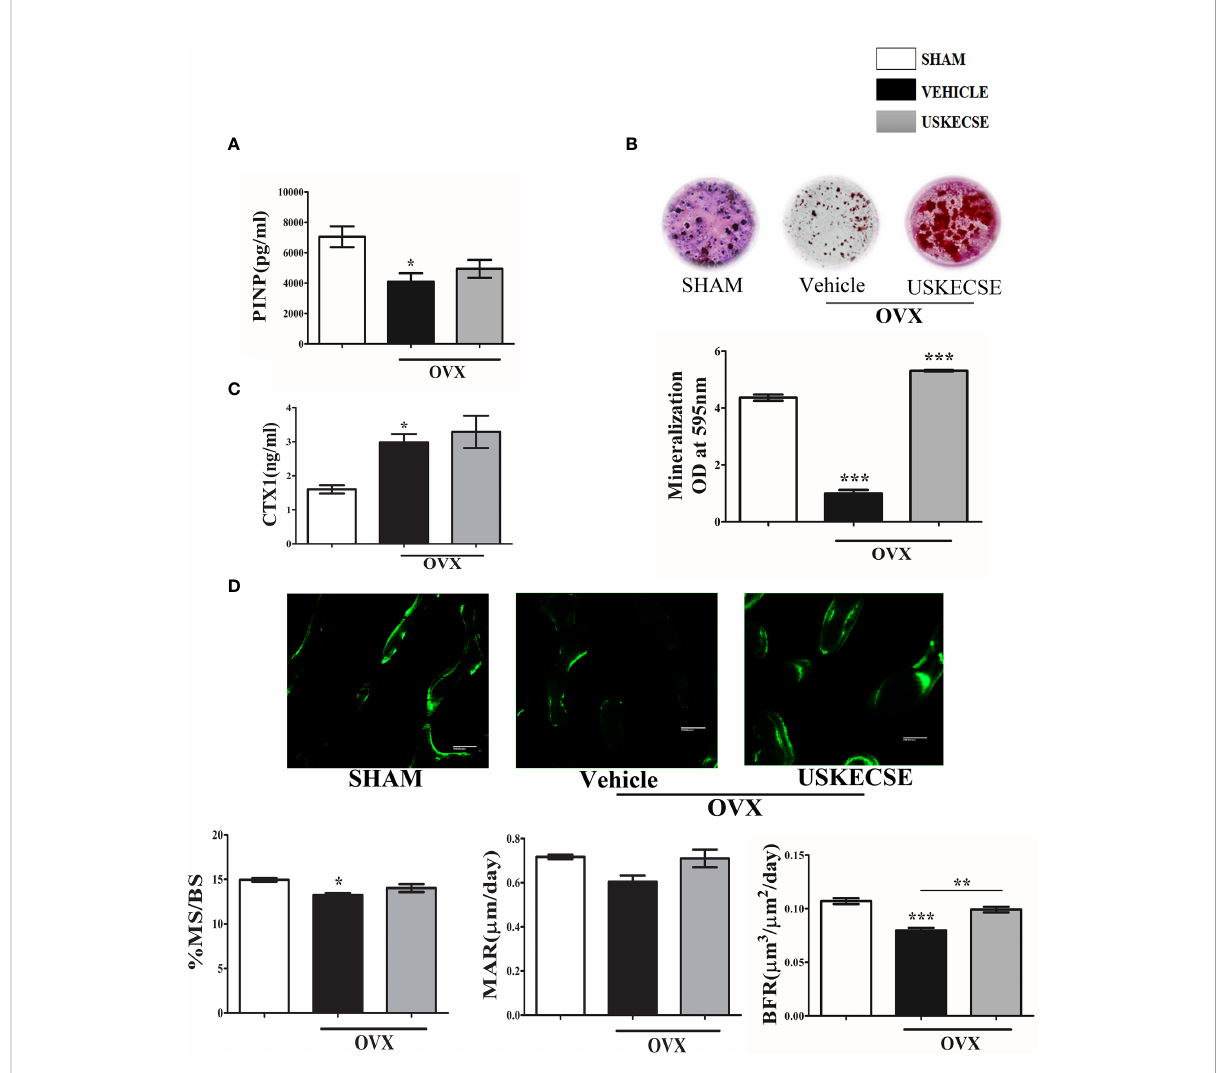
FIGURE 7 USKECSE has an osteoanabolic effect in osteopenic rats. (A) Serum procollagen type I N-propeptide (PINP). (B) Ex vivo mineralization assay was performed in samples obtained from the indicated groups. (C) Cross-linked C-telopeptide of type I collagen (CTX1) levels were determined by ELISA from the urine of rats with indicated treatments. (D) Upper panel showing representative images (scale bar, 100 m m) of double calcein labeled surface at femur metaphysis and the lower panel showing dynamic histomorphometry parameters in the indicated groups. For ELISA, serum samples of n = 6 rats from each group were taken, and for ex vivo mineralization and histomorphometry femurs, sections of n = 3 rats from each group were used. Values are expressed as mean ± SEM; * p <.05, ** p <.01, and *** p <.001 vs.